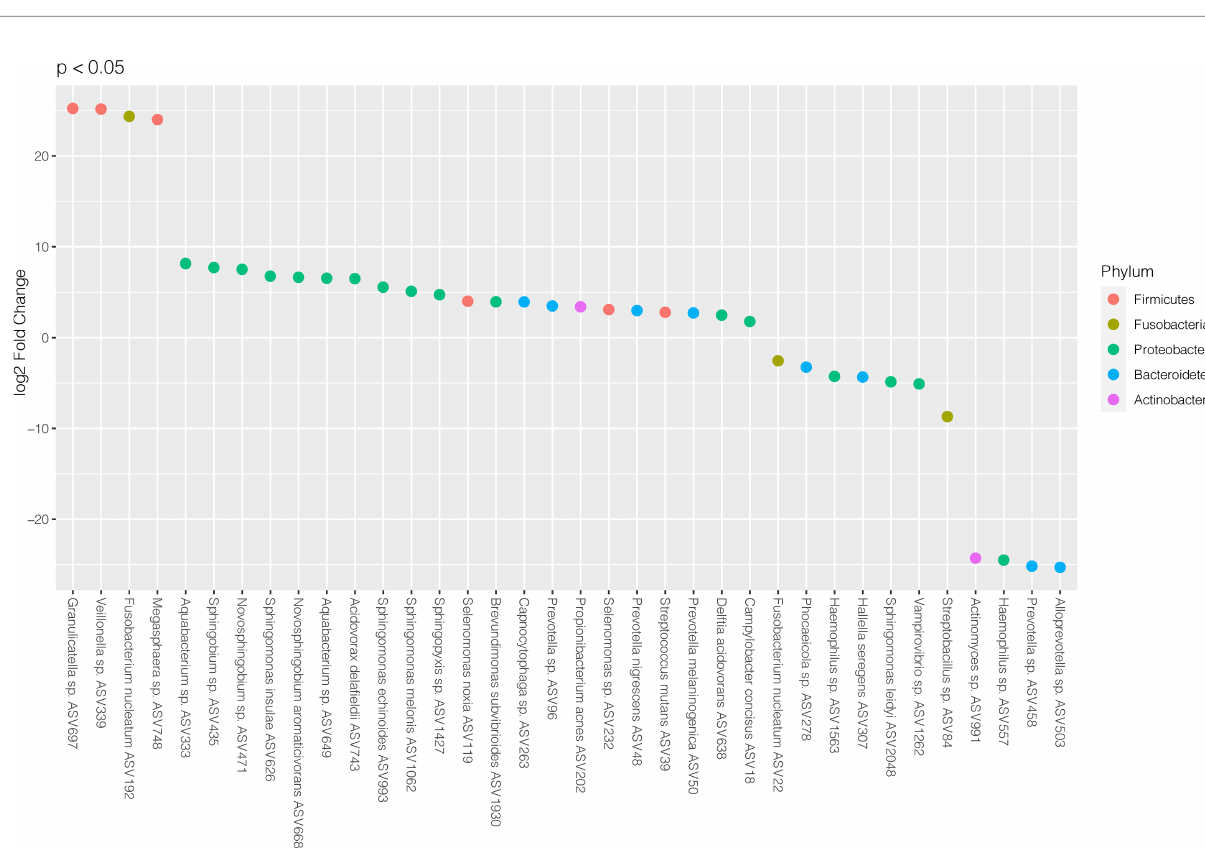
FIGURE 2 | Differentially abundant amplicon sequence variants (ASVs) identi fi ed through DESeq2 testing. Each ASV is shown as its lowest annotated taxonomic rank together with its ASV ID. The ASVs are color-coded according to the phyla they belong to and plotted according to their log2 fold change (log2 FC), calculated as the levels in samples from patients with RA and periodontitis relative the levels in samples from periodontitis patients without RA, with size factor normalization as implemented in